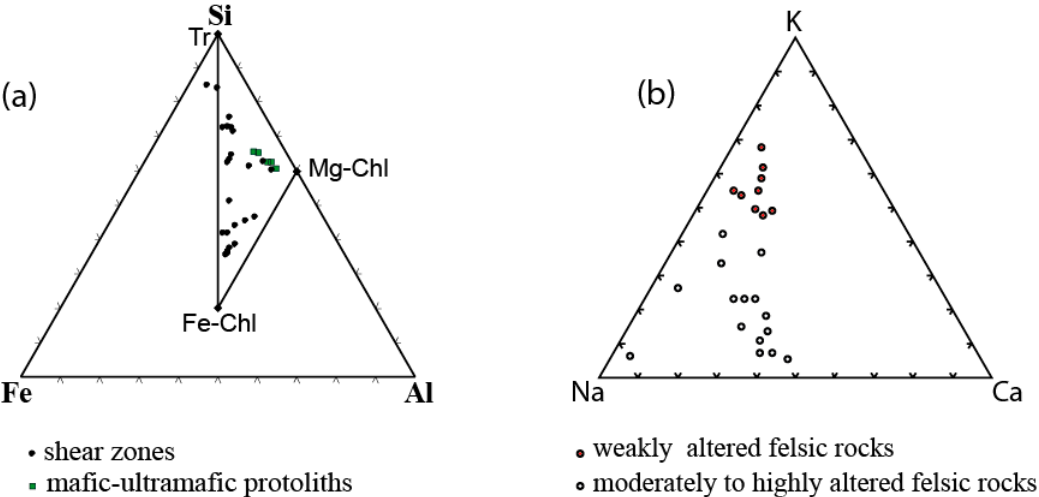
Figure 7. ( a ) Projection of the Kettara shear zones in Si, Fe, and Al ternary diagram (cation proportions). The whole rock composition of the Kettara shear zones evolves toward the Fe-chlorite-tremolite (Tr) join; and ( b ) Ternary K–Na–Ca diagram (cation proportions) showing enrichment in Na ± Ca in the altered felsic rocks; modified from [70,109].